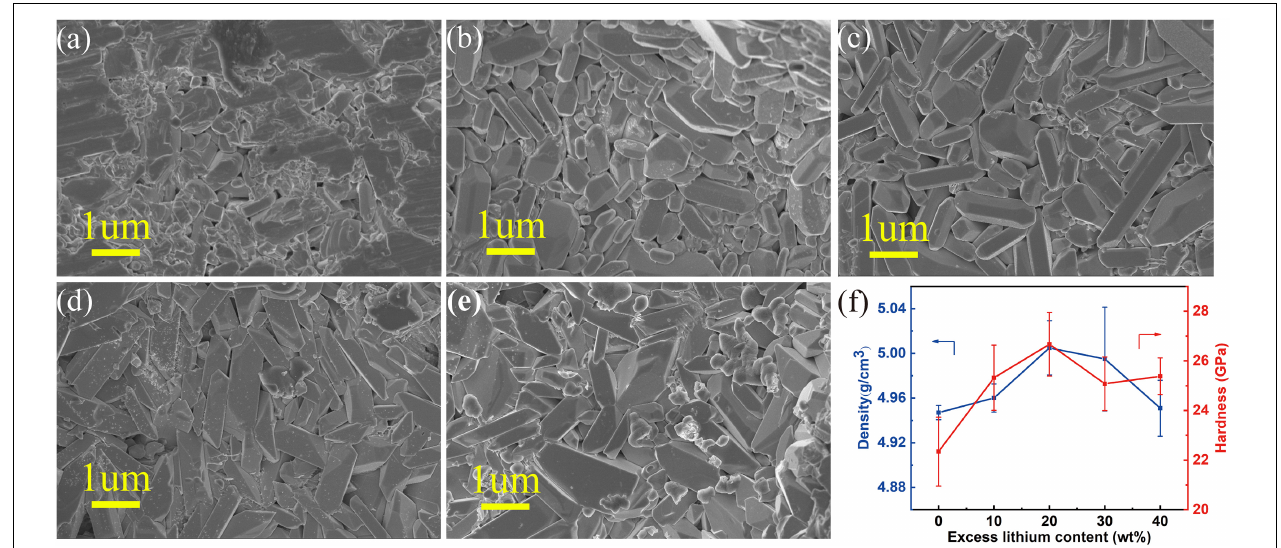
FIGURE 2 | SEM, density, and hardness under different lithium additions, (a–f) are represented as 0, 10, 20, 30, 40 wt%, and density, hardness graph.